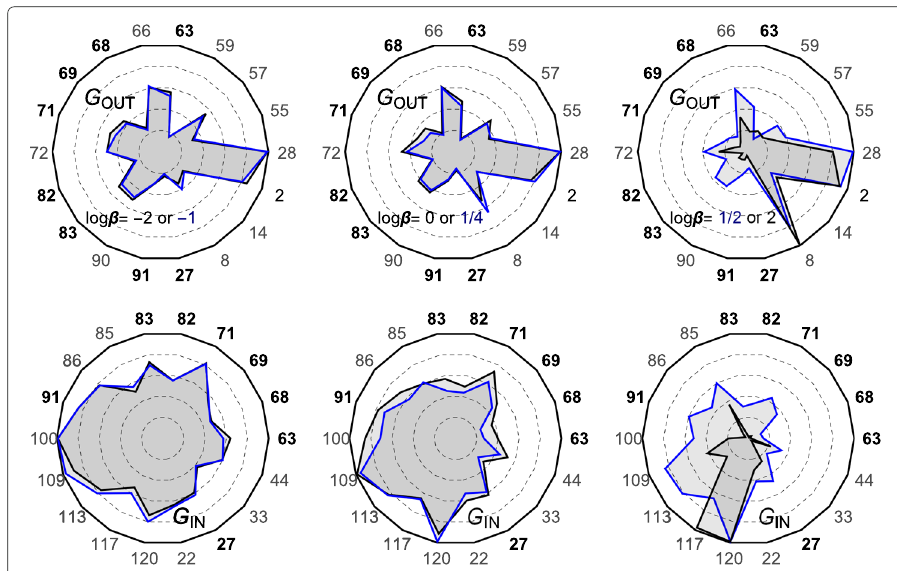
Fig. 6 Radar maps of the key concepts obtained as averages. The radar map representation of the 18 most important key concepts obtained by averaging the values of communicabilities over 12 individual concept network. The weighting of links is as denoted in upper row (note the colour annotation). The out- and in-communicabilities are shown in the upper and lower rows,